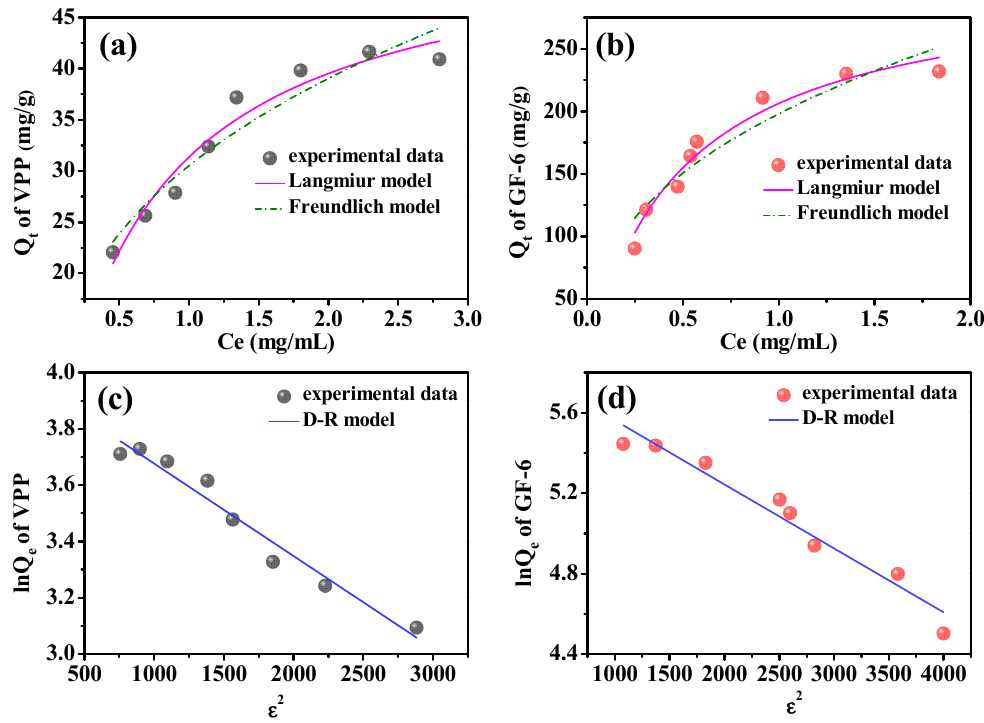
Figure 8. Adsorption isotherm of AmZPP 5000 for VPP ( a , c ) and GF-6 ( b , d ) fitting by Langmuir, Freundlich and D–R models. Table 3. Adsorption isotherm parameters of AmZPP 5000 for VPP and GF-6. Langmuir Model